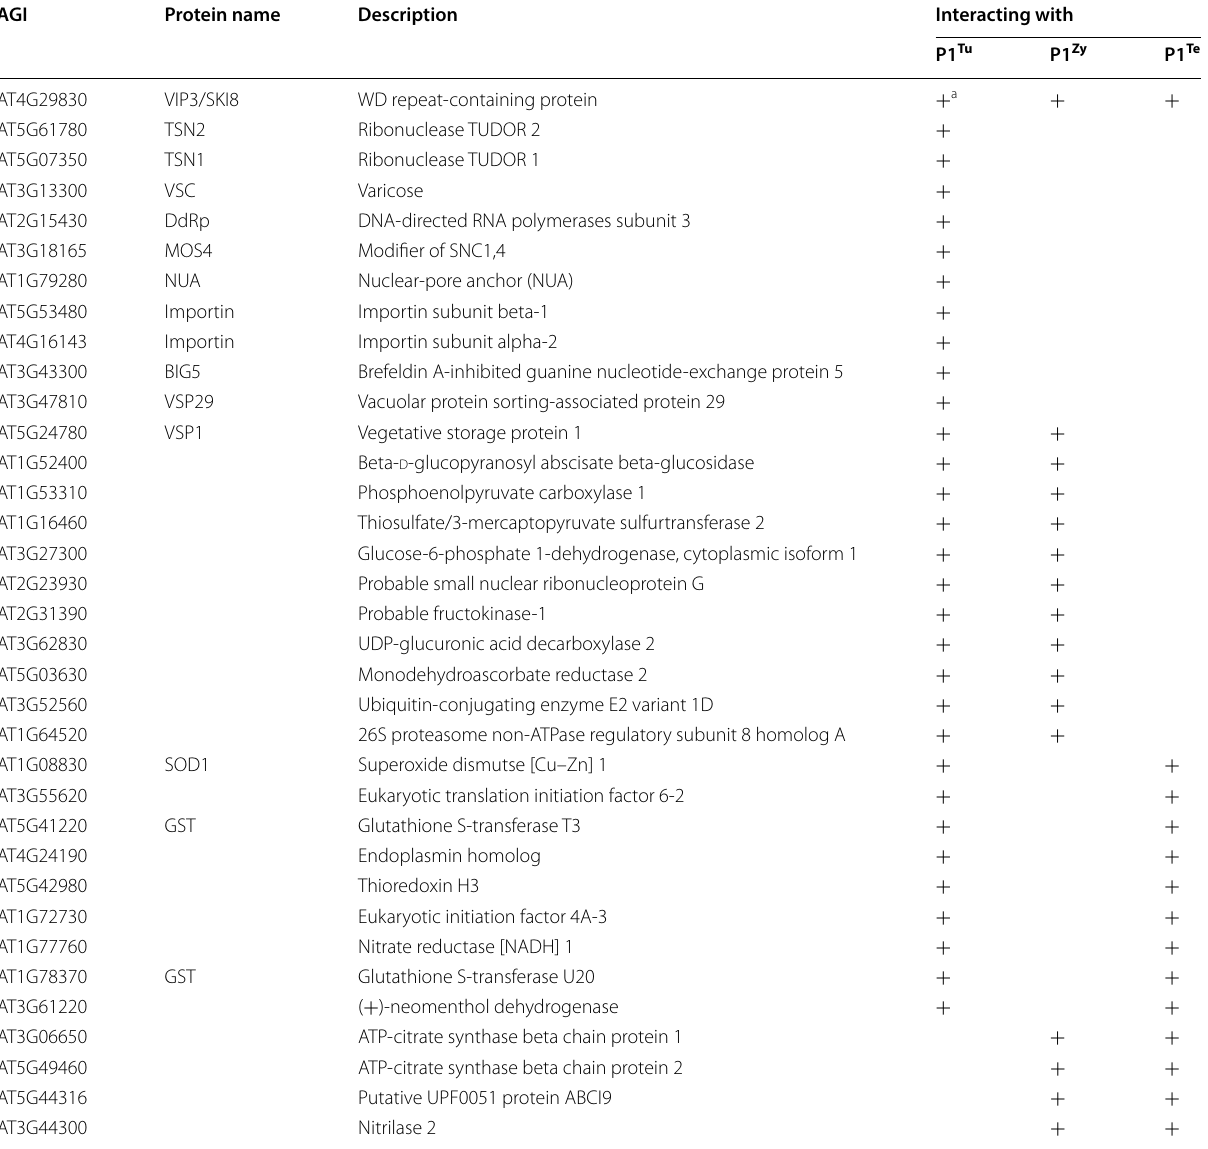
a The protein was identified in the relevant P1 transgenic plants and marked as “